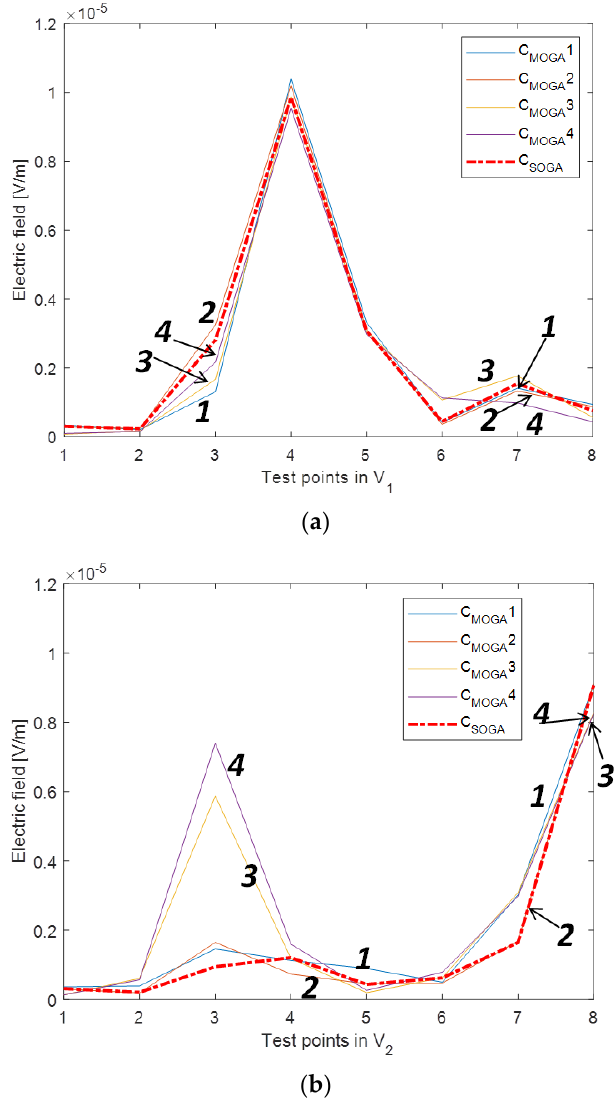
Figure 9. Magnitude of the electric field in ( a ) the N 1 test points of volume V 1 and ( b ) the N 2 test points of volume V 2 , due to the optimal MOGA solutions C MOGA i with constraint N r = 5 in Table 2.